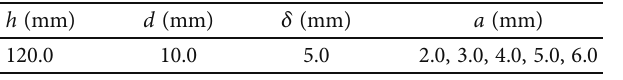
Figure 8: The unilateral crack specimen and tensile test Table 1: The sizes of propellant unilateral crack specimen.